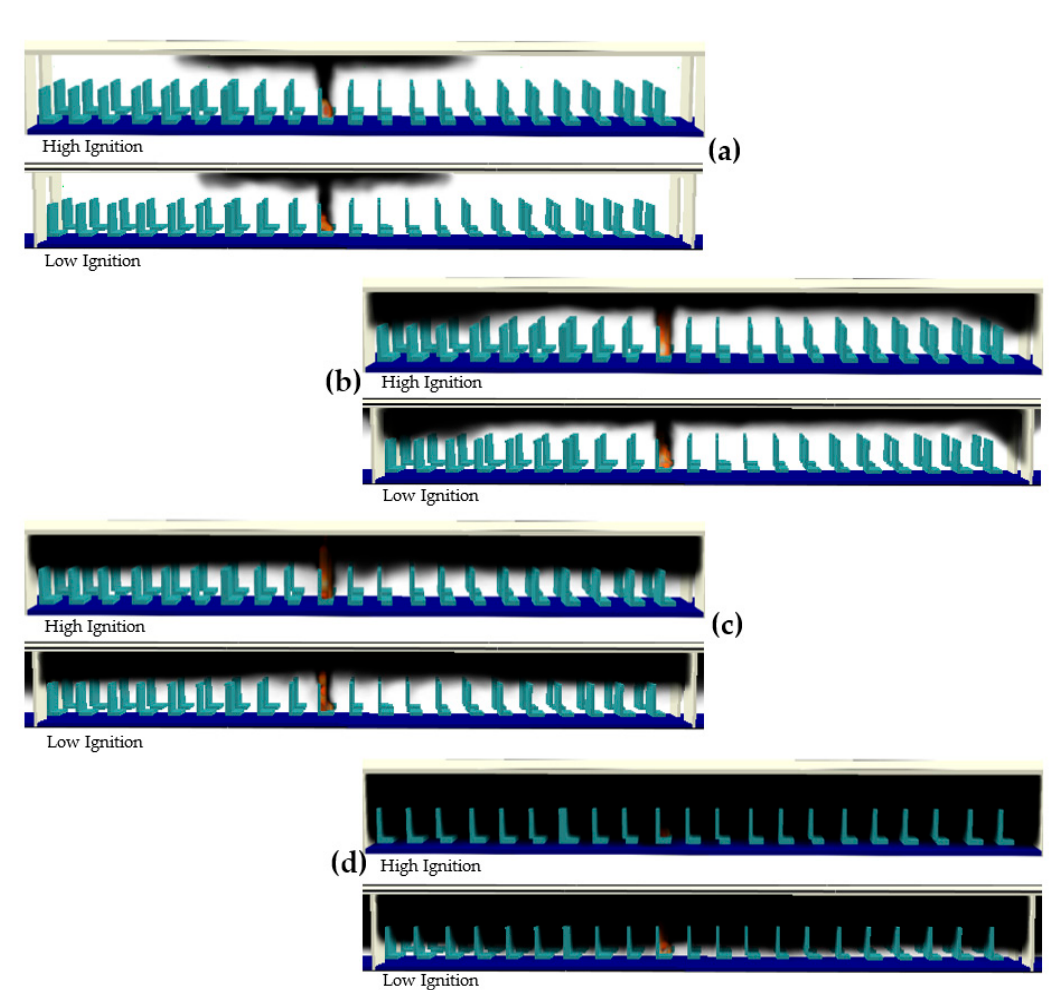
Figure 8. Smoke distribution due to varying ignition energy at ( a ) 10 s, ( b ) 30 s, ( c ) 50 s, ( d ) 100 s.